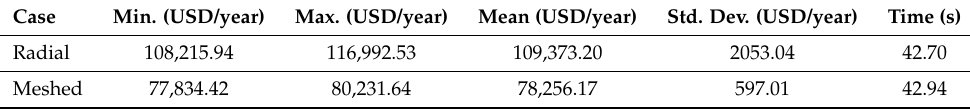
Table 9. Statistical analysis for the radial and meshed configurations of the IEEE 33-bus